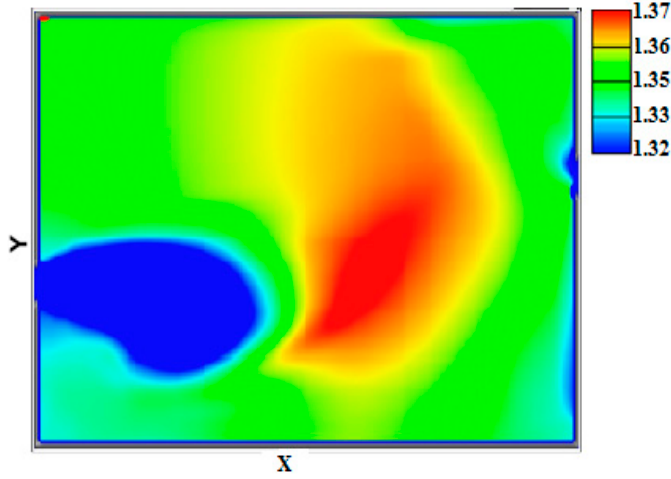
Figure 5. The pattern of sediment deposition in G374 reservoir.